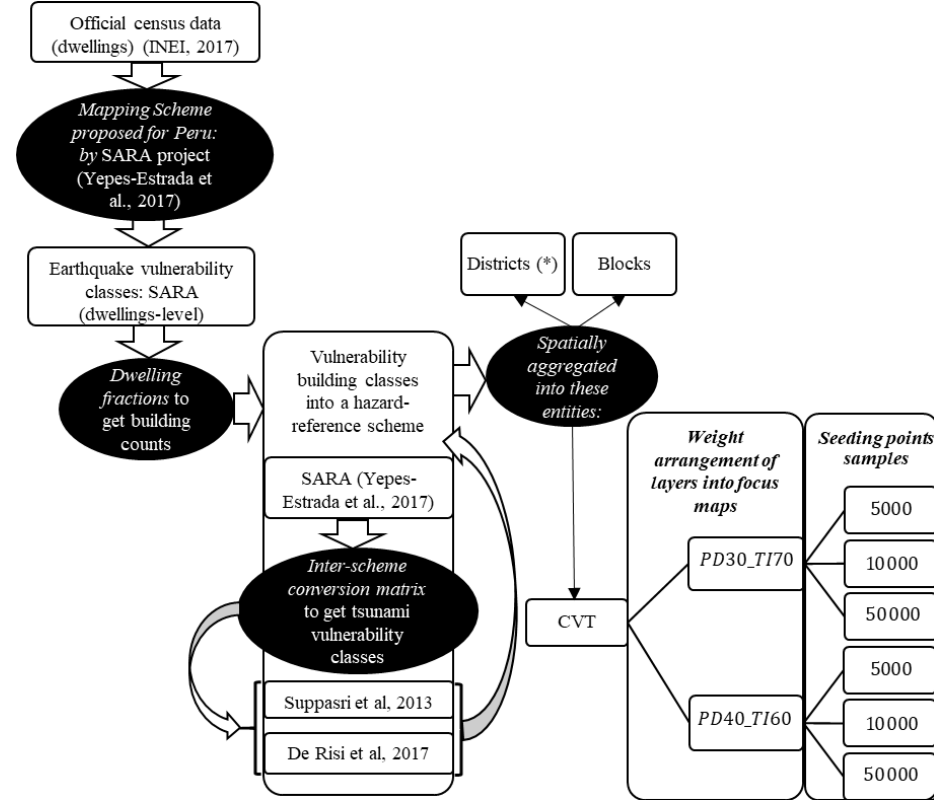
Figure 8. Flowchart outlining the process for constructing the building exposure model for metropolitan Lima, including the condition tree used for the construction of CVT-based exposure models for the aggregation of earthquake and tsunami vulnerability building classes. (*District-based aggregation entities are only used for seismic risk to compare absolute loss values.)